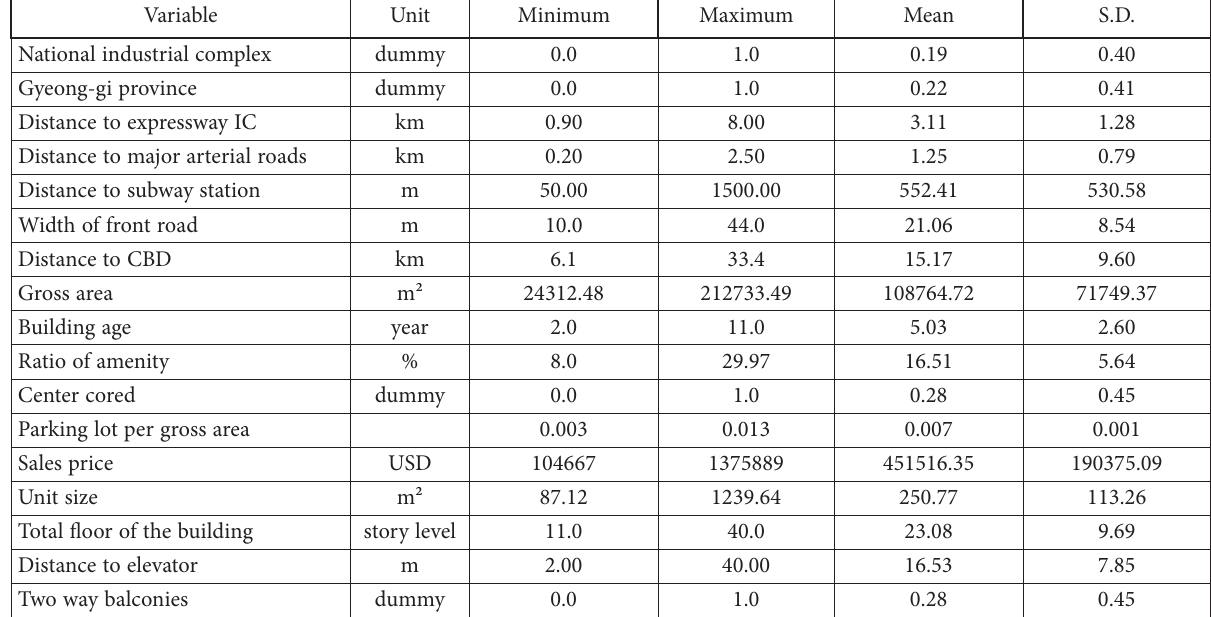
Table 6. Descriptive statistics (N =